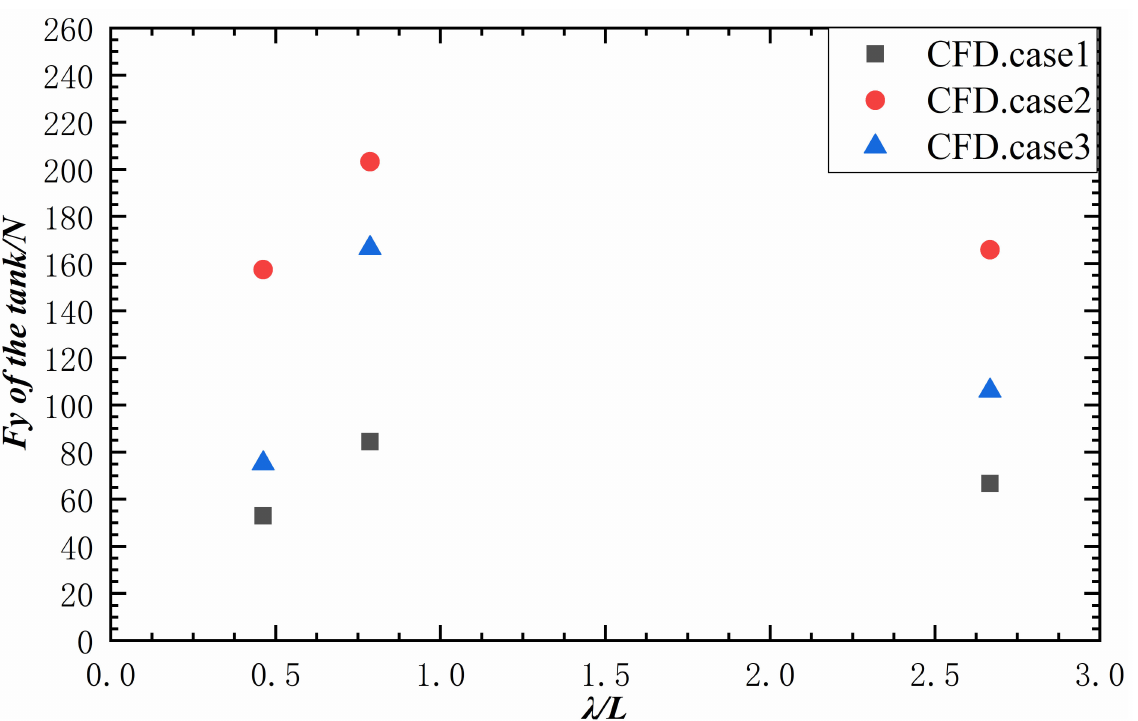
Figure 25. The amplitude of transverse force on the tank (Case 1: The size of the tank is 0.57 × 0.57 × 0.5 m, and the height of liquid in the tank is 0.1 m; Case 2: The size of the tank is 0.57 × 0.57 × 0.5 m, and the height of liquid in the tank is 0.2 m; Case 3: The size of the tank is 1.17 × 0.57 × 0.5 m, and the height of liquid in the tank is 0.1